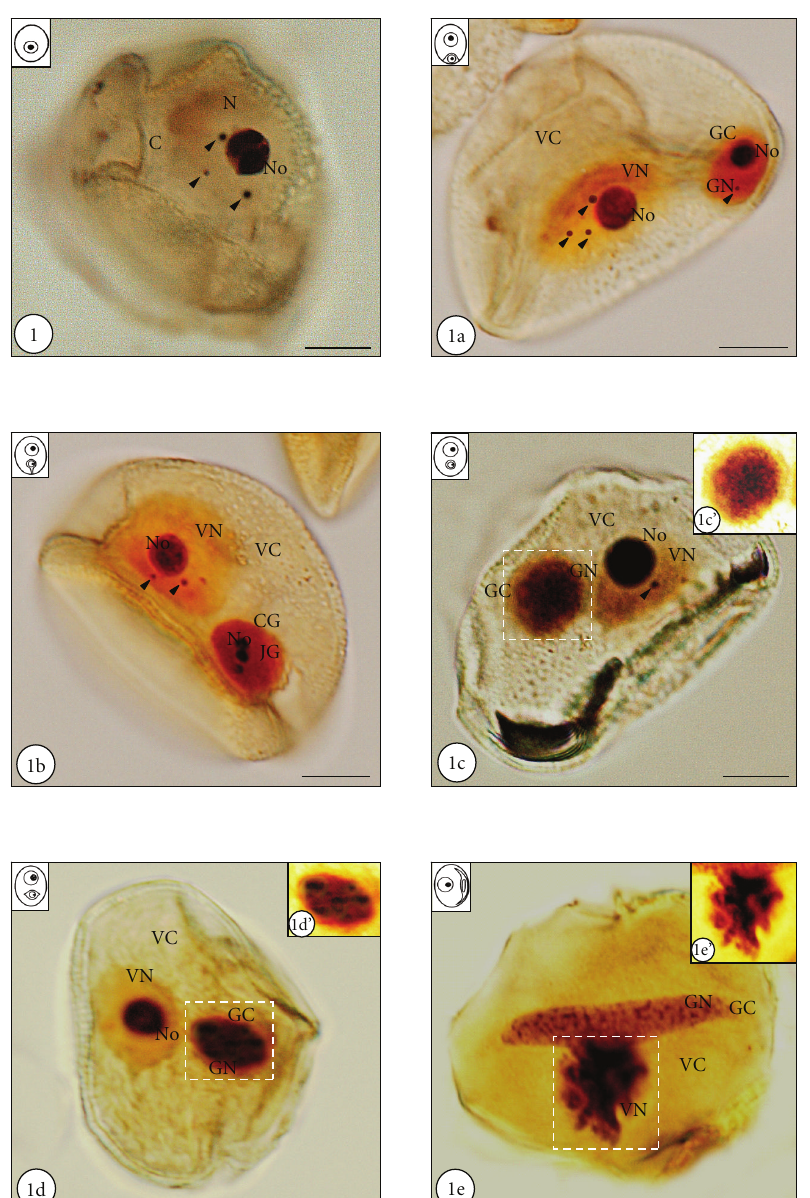
Figure 1: Hyacinthus orientalis L. silver nitrate-stained microspore and developing pollen grains (N-nucleus, No-nucleolus, VN-vegetative nucleus, VC-vegetative cytoplasm, GN-generative nucleus, GC-generative cytoplasm). Bars-10 μ m. Figure 1. In the nucleus of the